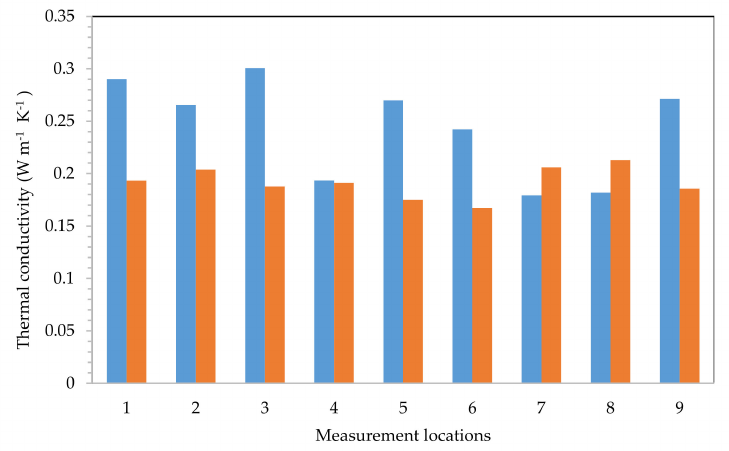
Figure 9. Local thermal characterization of the cob structural and cob insulating samples.